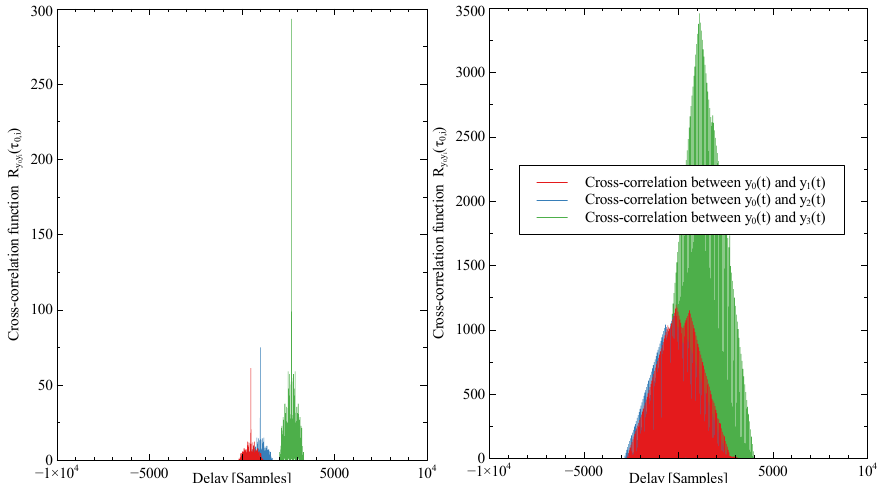
Figure 11. Example of the cross-correlation function for delay estimation. Left : Signals without jamming. Right : Signals with the randomly placed jamming device. If the jammer is used, the signals reflected from the target are hidden. Hence the algorithm is not able to estimate the correct